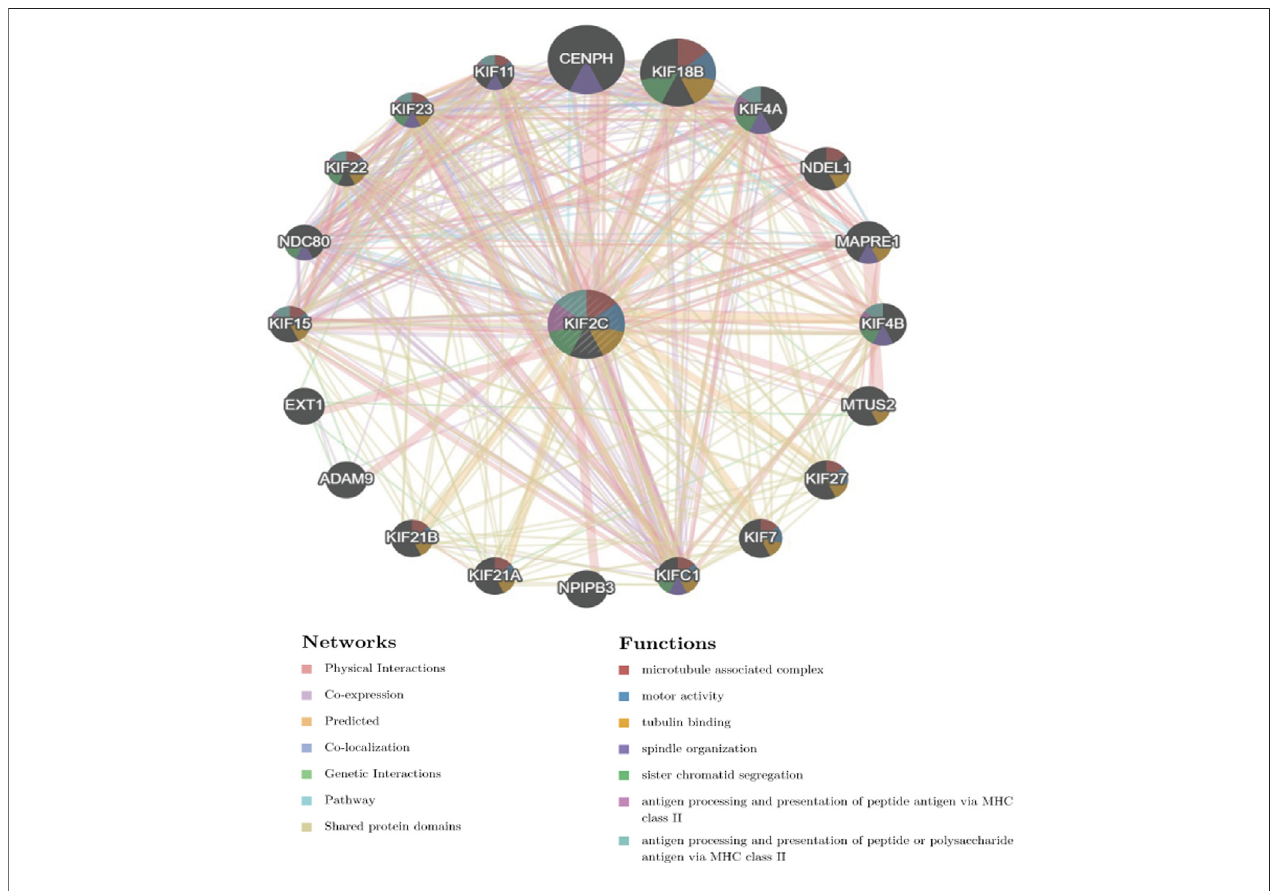
FIGURE 11 | PPI network of KIF2C constructed using the GeneMania database.